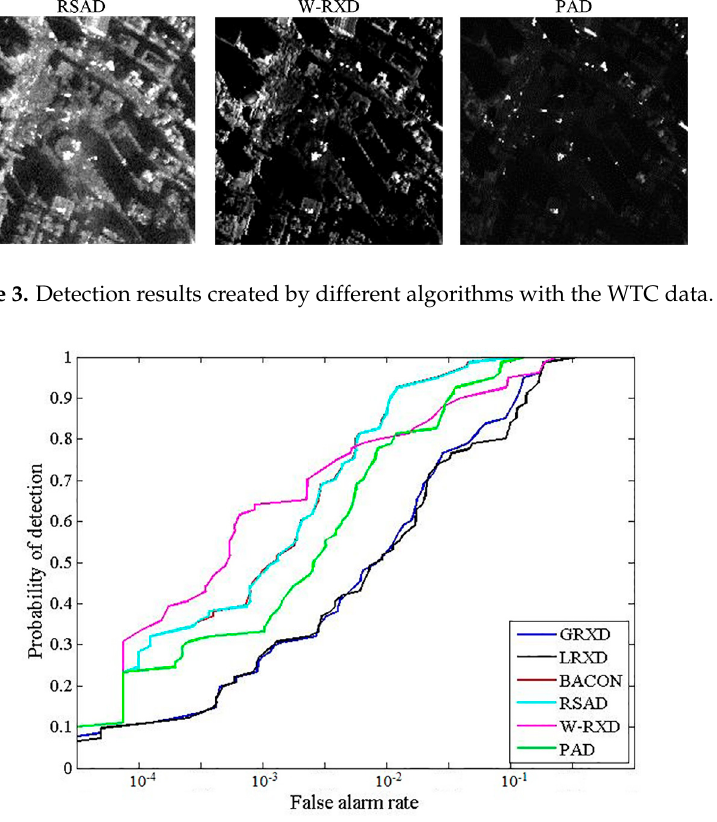
Figure 4. ROC curves corresponding to the detection results presented in Figure 3. Table 1. The statistic and stretching information of the six grayscale images for the WTC data set.